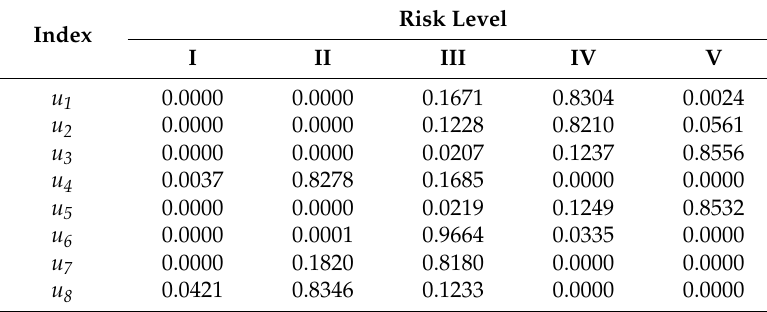
Table 20. Certainty degrees of Anshun City in Guizhou